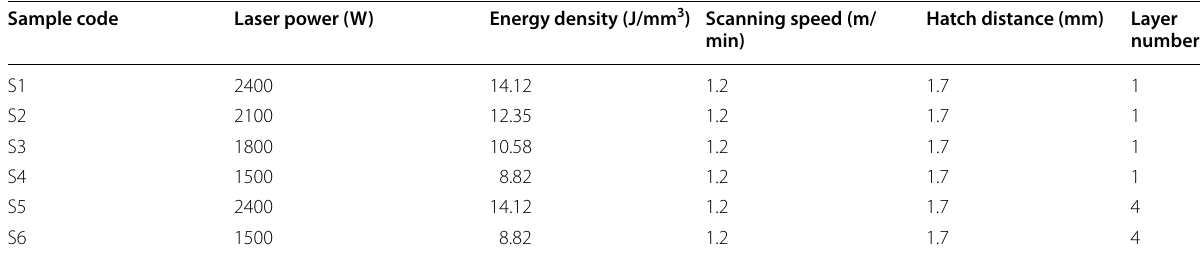
Table 2 Laser cladding parameters Sample